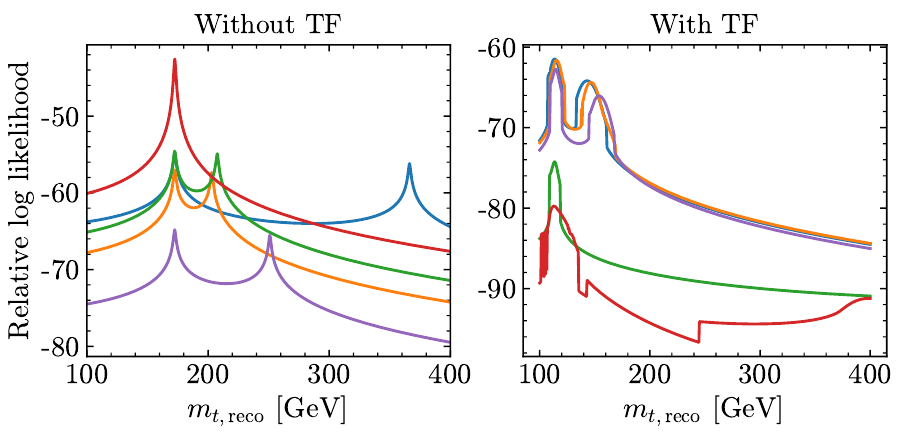
Figure 7 . The left panel shows double peak structure of the log likelihood function for 5 random events at truth level, without including the transfer functions. A clear double peaked structure occurs for many events. As expected, the lower mass peak is always more likely than the higher mass one. The right panel shows the impact of including the transfer functions in the likelihood and optimizing over the z -component of the neutrino momentum for the same (cid:12)ve events, as im- plemented in KLFitter . Although the transfer functions push the peaks together, they do not always result in a likelihood that has a single local maximum. Note that the absolute scale of the log likelihood is expected to di(cid:11)er between the two